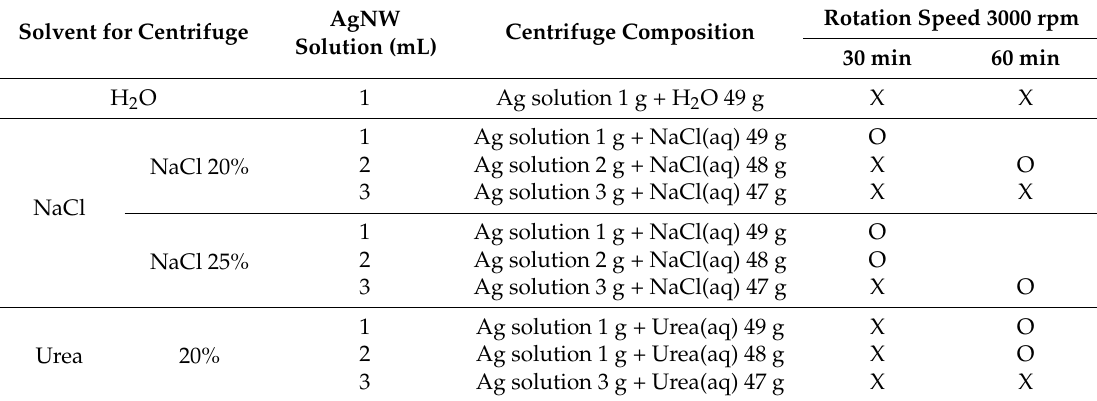
Table 3. Search of recovery solvent for AgNWs from AgNW/EG reaction mixture. Solvent for